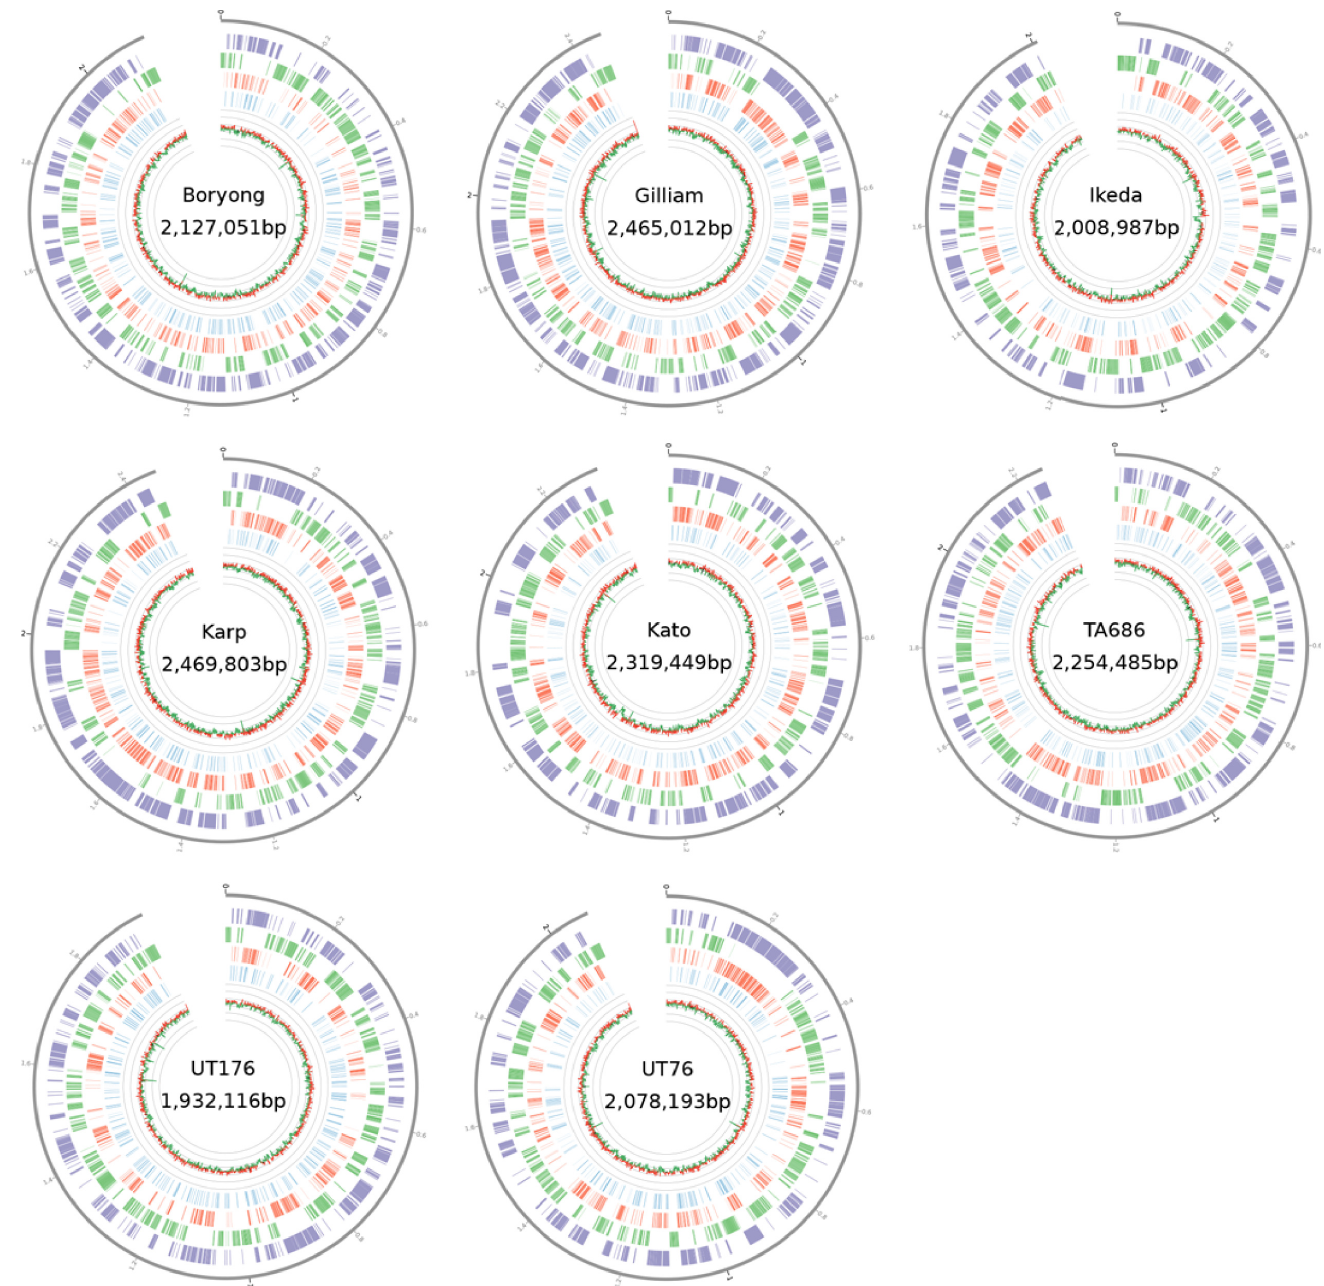
Fig 1. Ring diagrams for all single-contig strains. From outermost feature in each genome, moving inwards: repetitive regions are shown in purple, core genes in green, repeat genes in red and pseudogenes in blue. The track shows the GC percentage in windows of 1000bp. Values above the median GC are in green, and values below the median GC are in